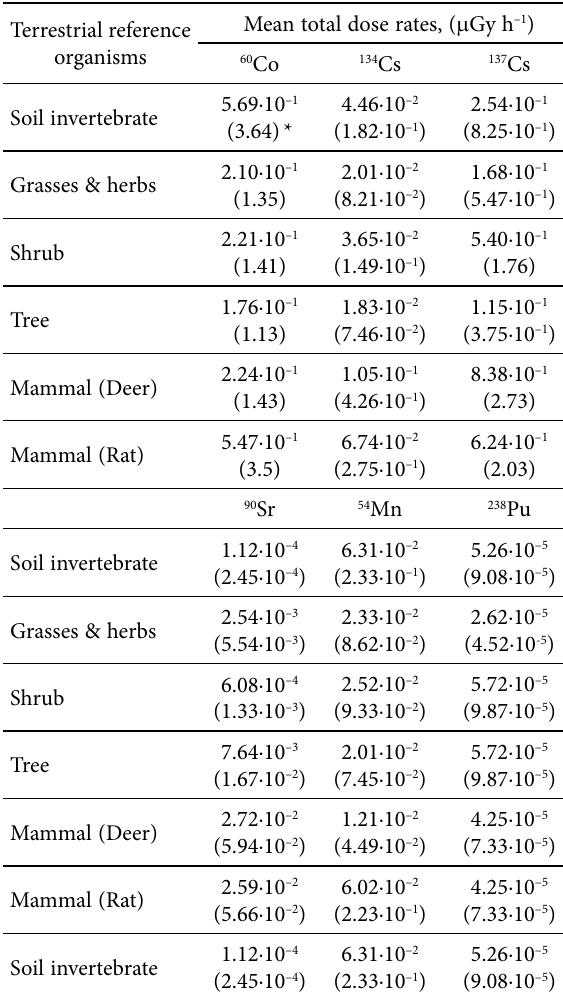
Table 3. Examples of ERICA evaluated exposure values of terrestrial ecosystem reference organisms at INPP operation